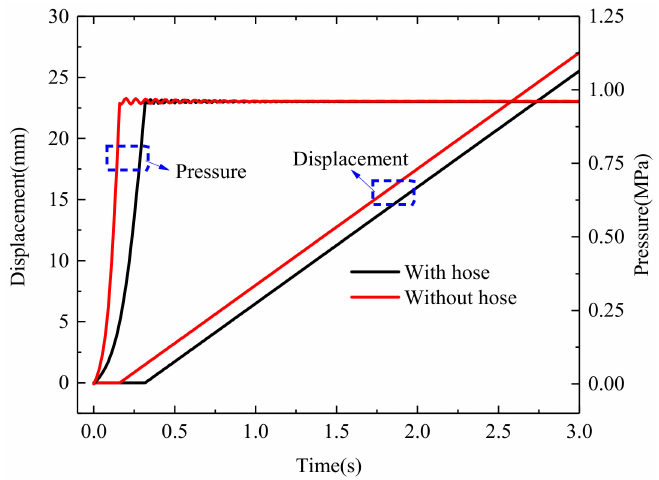
Figure 4. Displacement of the target cylinder and pressure in the rodless